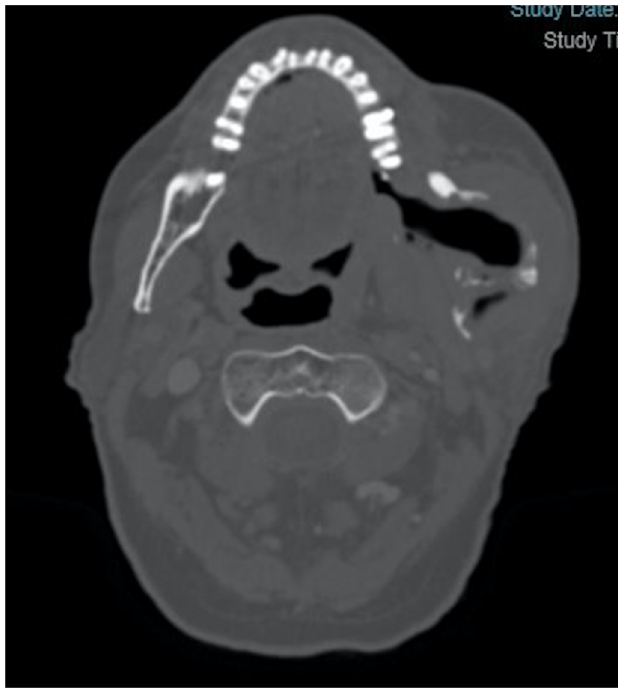
Fig. 5. Facial scan (bone window) in axial section 1 year after radiotherapy showing a stabilization of this expansive process and communication with the oral cavity.